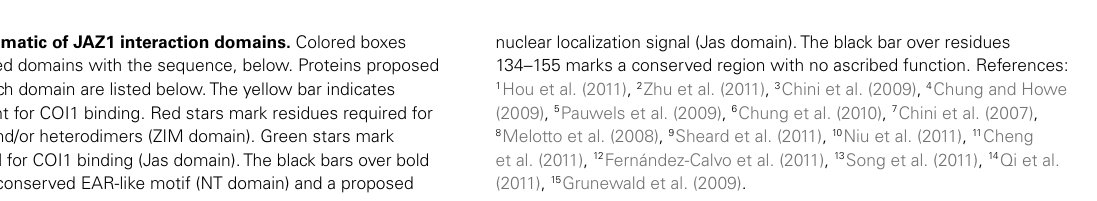
nuclear localization signal (Jas domain).The black bar over residues 134–155 marks a conserved region with no ascribed function. References: 1 Hou et al. (2011), 2 Zhu et al. (2011), 3 Chini et al. (2009), 4 Chung and Howe (2009), 5 Pauwels et al. (2009), 6 Chung et al. (2010), 7 Chini et al. (2007), 8 Melotto et al. (2008), 9 Sheard et al. (2011), 10 Niu et al. (2011), 11 Cheng et al. (2011), 12 Fernández-Calvo et al. (2011), 13 Song et al. (2011), 14 Qi et al. (2011), 15 Grunewald et al.